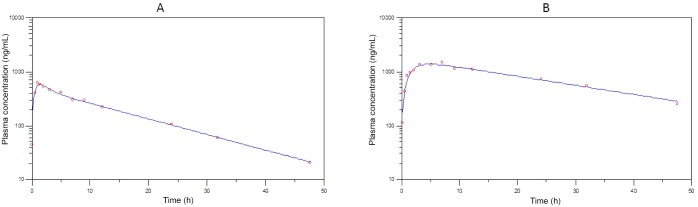
Plasma concentration versus time after dosing, plot (dots) with best fit curve (lines) for bird 1 (A) and 2 (B) following oral administration of carprofen (11.5 mg/kg).Samples were collected sequentially, when possible, at 5 and 30 min; 1, 1.5, 2, 3, 5, 7, 9, 12, 24, 32 and 48 hours after treatment with carprofen.